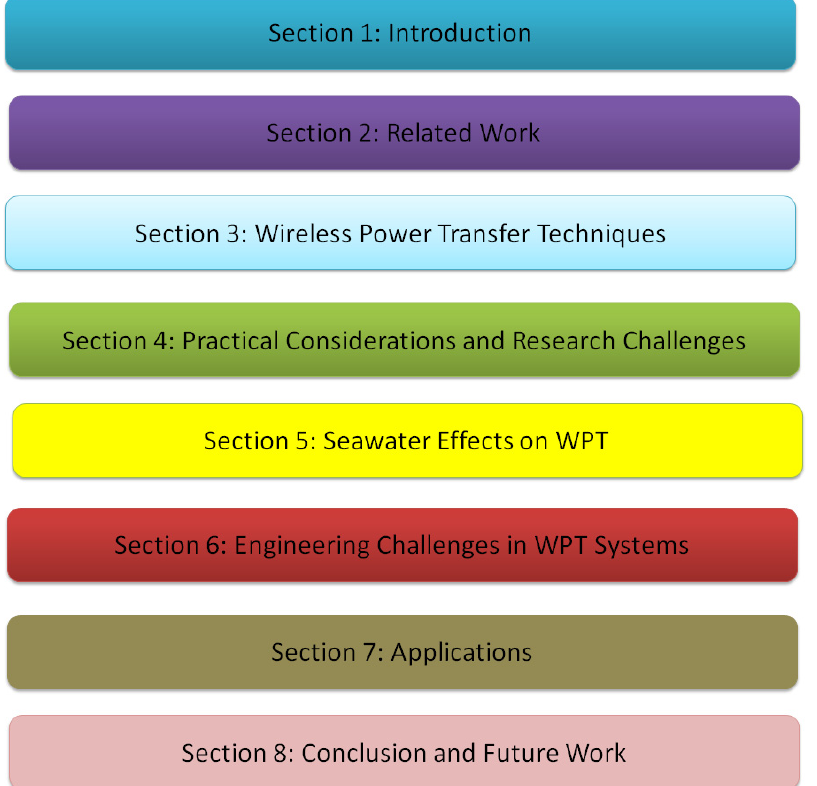
Figure 4. Organization of this study.